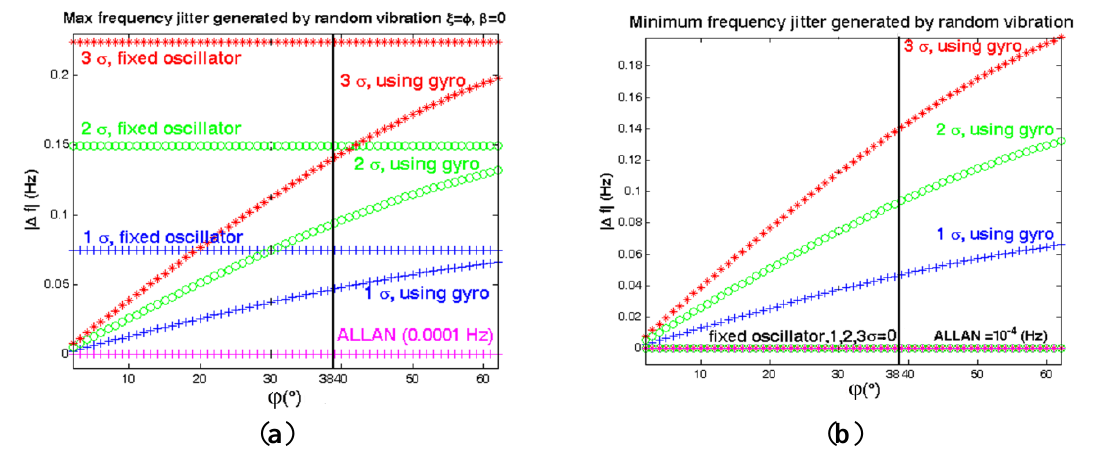
Figure 23. Comparison between system instability in different states. ( a ) Maximum state ξ = φ, β = 0; ( b ) Minimum state, ξ − φ = 90°or β =